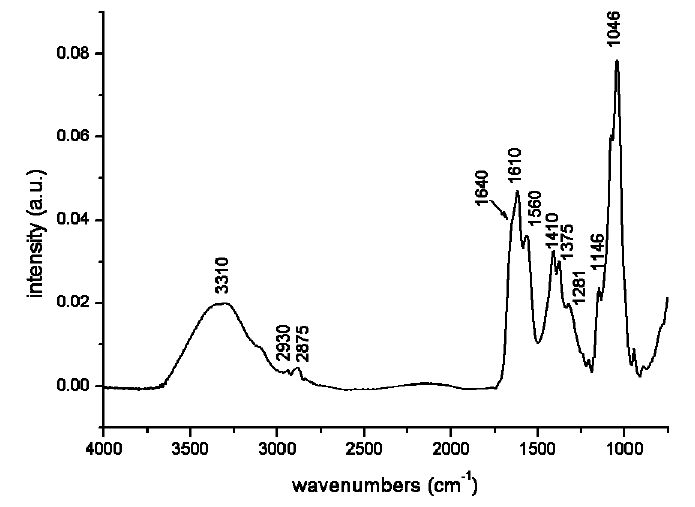
Figure 7. Infrared spectrum of native Hyal hydrogel in the region between 4000 and 750 cm − 1 .